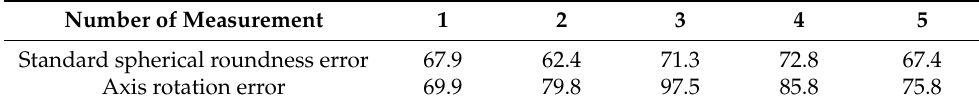
Table 1. Repeatability test results of measurement system (standard sphere A)